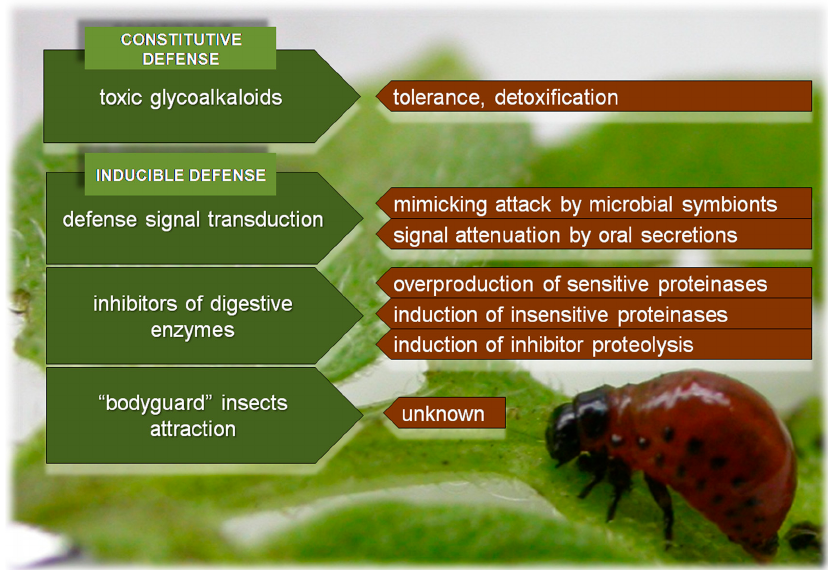
Figure 2. Potato defense strategies (green boxes) and the reciprocal CPB countermeasures (red boxes) that reflect co-evolutionary “arms race” between these two species.